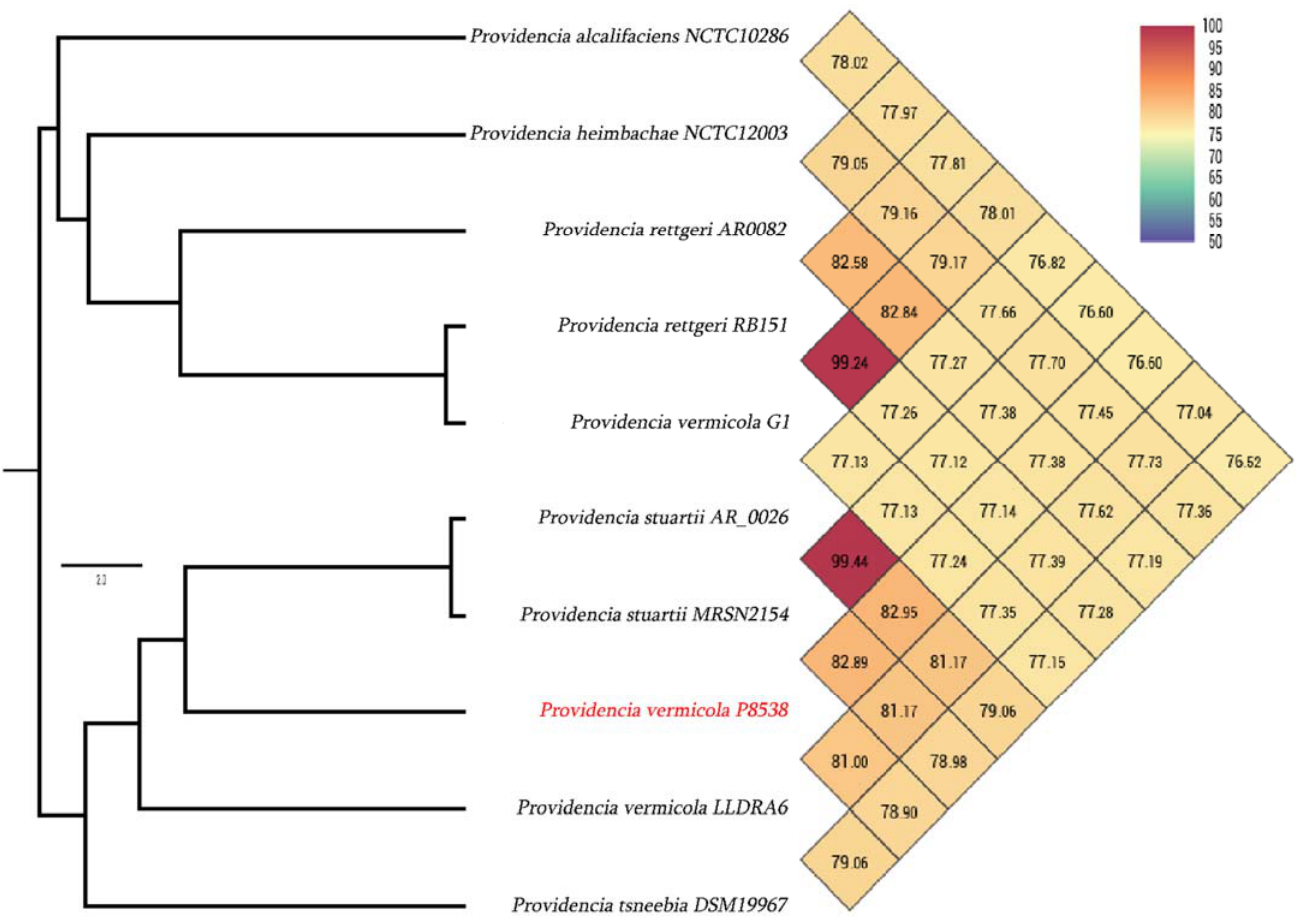
Figure 4. Average nucleotide identity comparison of P. vermicola P8538 with Providencia species using the OrthoANI soft- ware.